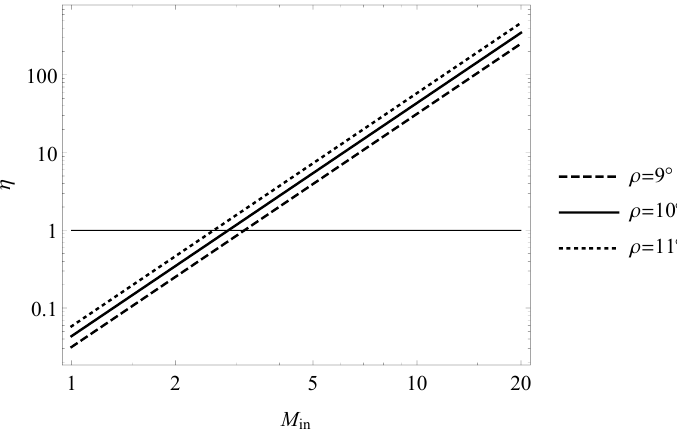
Figure 7. Dependence of the ratio of the jet and surrounding medium densities η on the Mach number in the jet flow for the parameters found for the blazar OJ 287 helical jet: the horizontal line marks η =